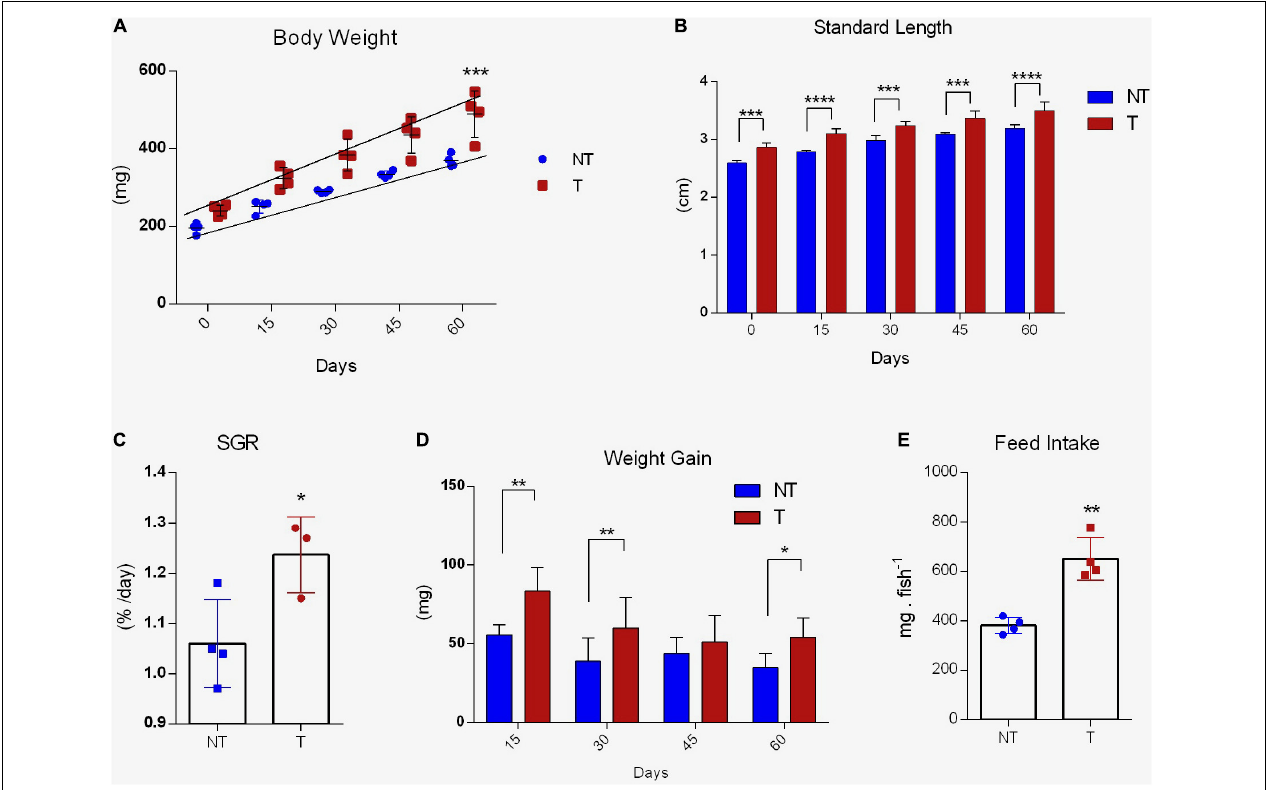
FIGURE 3 | Growth performance and feed intake of gh -transgenic zebrafish ( D. rerio ). Body weight (A) , length (B) , SGR (C) , weight gain (D) , and feed intake (E) were significantly increased in response to GH excess in transgenic zebrafish compared to non-transgenic full siblings. Weight (mg) and length (mm) were measured every 15 days during the 60-day growth experiment (non-transgenic, n = 38, and gh -transgenic fish, n = 37). Differences in body weight between the two groups were determined by linear regression analysis. ANOVA with multiple comparisons was performed between the two genotypes at each time point for weight gain and body length. Comparisons of SGR and feed intake between two groups were taken by a two-tailed t -test. Data are shown as means ± SE of 37 fish per group. Asterisks indicate significant differences (* p < 0.05; ** p < 0.01; *** p < 0.001; and **** p < 0.0001). Zebrafish that overexpress GH exhibited a linear increase in growth ( p < 0.05). gh , growth hormone gene; NT, Non-Transgenic; T,